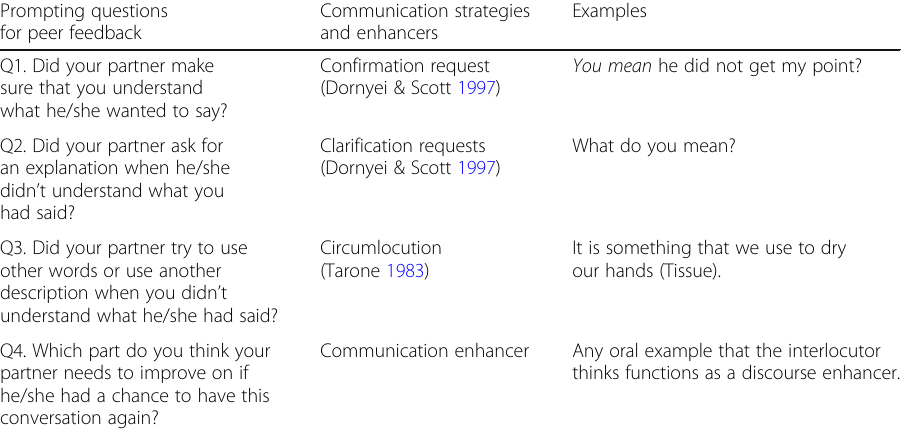
Table 2 Prompting questions and communication strategies and